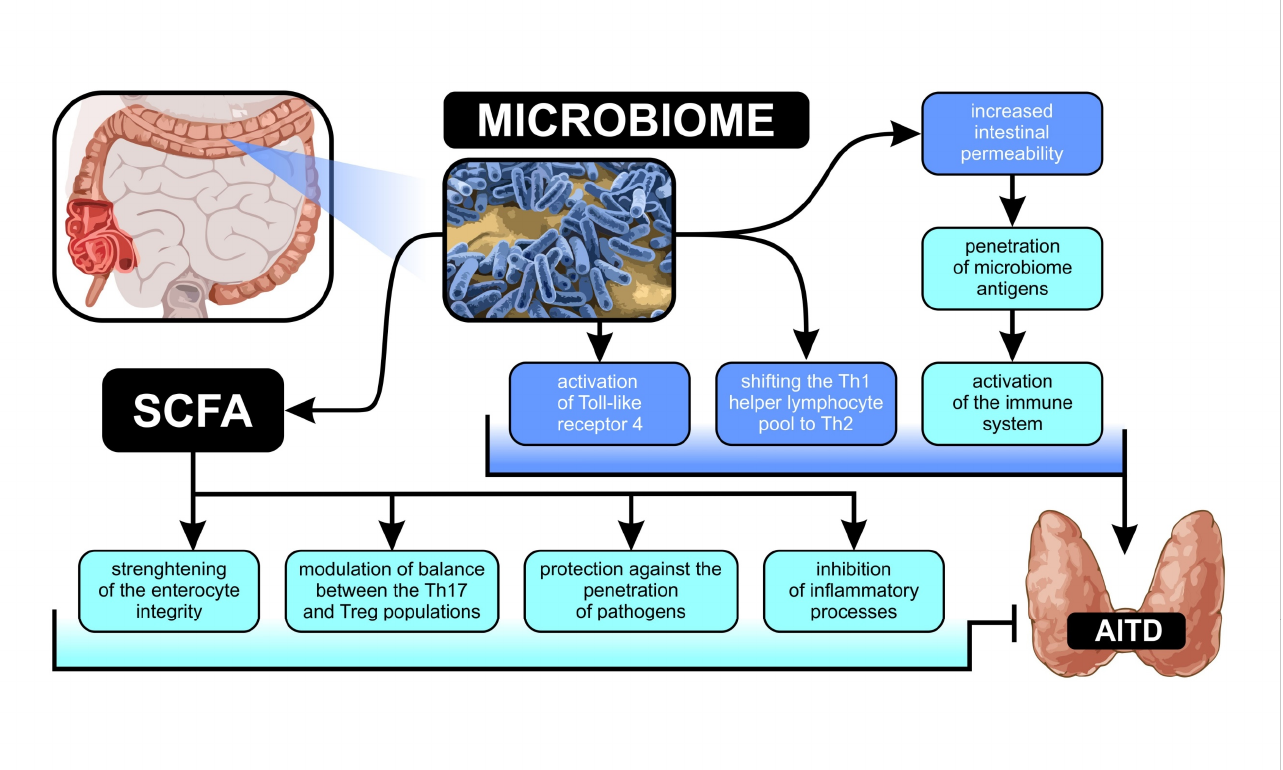
Figure 1. Potential relationships between alterations in gut microbiota and autoimmune thyroid disease pathogenesis. (AITD, autoimmune thyroid disease; SCFA, short-chain fatty acid).